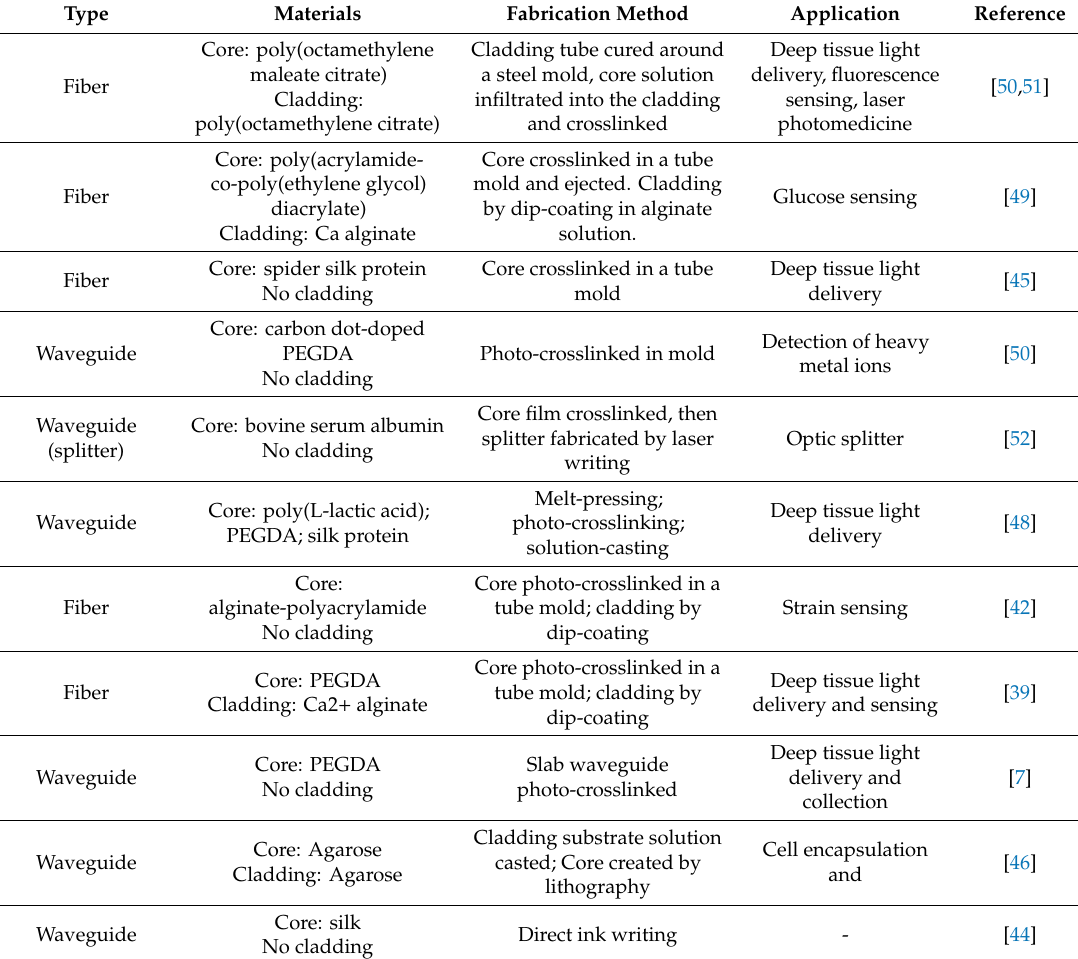
Table 1. Soft biopolymer-based optical fibers and